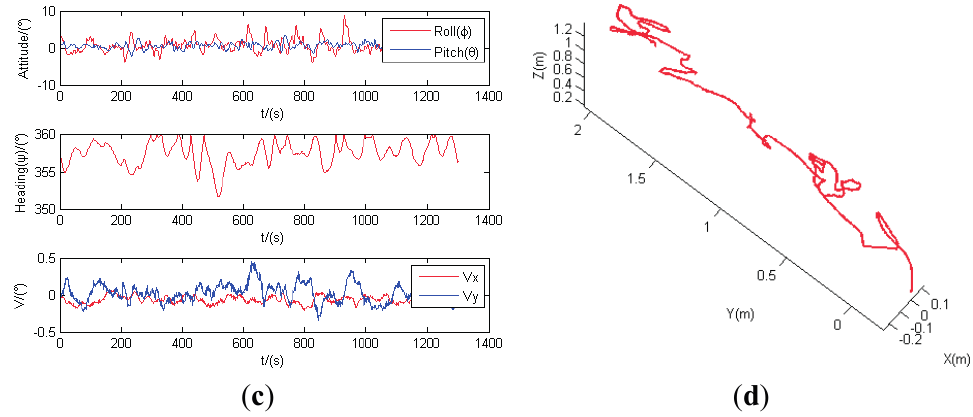
Figure 9. State estimation results. ( a ) Attitude and velocity estimates of Scenario 1; ( b ) estimated position vs. ground truth trajectory of Scenario 1; ( c ) attitude and velocity estimates of Scenario 2; ( d ) estimated position of Scenario